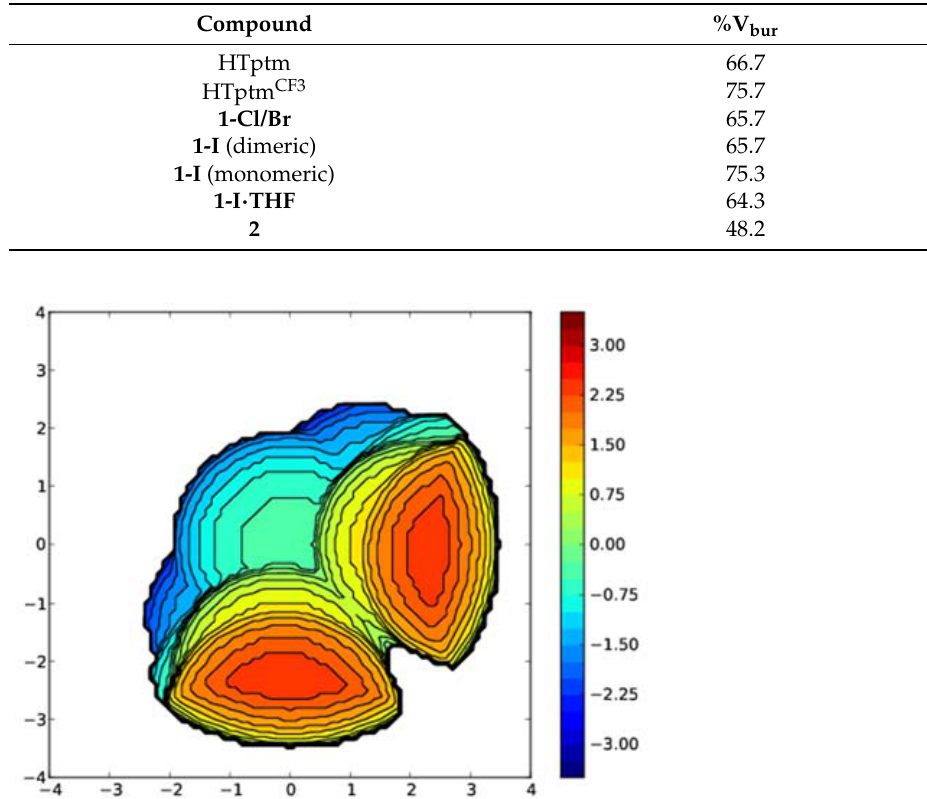
Table 2. Buried volume calculations using crystallographic coordinates of HTptm and HTptm CF3 , along with complexes of Tptm and 2 . 1-Br and 1-Cl are isostructural.